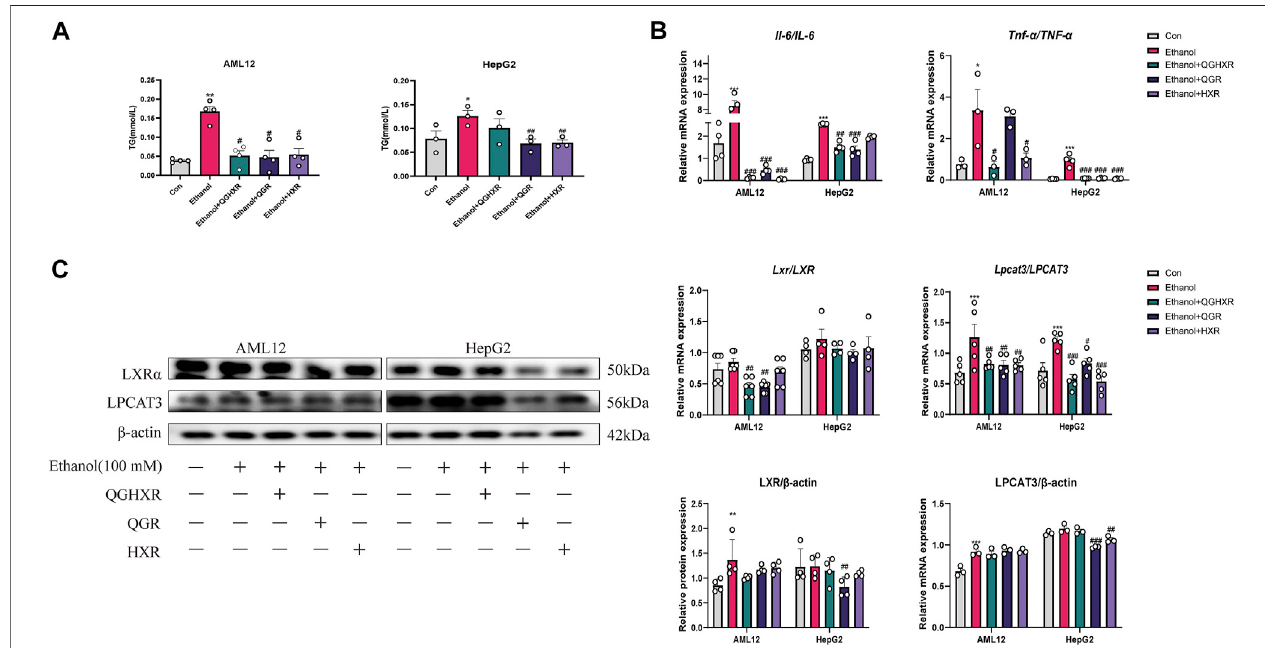
FIGURE 3 | Protective effect of QGHXR against alcohol-induced liver injury in AML12 and HepG2 cell involved modulation of LXR α and LPCAT3. (A) Level of TG (mmol/L) in AML12 and HepG2 cell. (B) mRNA expression of Il-6 and Tnf- α in AML12 cell and HepG2 cell. (C) mRNA and protein expression of LXR and LPCAT3 in AML12 and HepG2 cell. Con: normal control group, ethanol: ethanol group (100 mM), ethanol+ QGHXR: Qinggan Huoxue Recipegroup induced byethanol; ethanol + QGR: Qinggan Recipe group induced by ethanol; ethanol + HXR: Huoxue Recipe group induced by ethanol. Quanti fi cation of mRNA and protein level expression wasnormalizedto β -actinlevels.Datawerepresentedasmeans±SEM.Comparedwiththenormalcontrolgroup,* p < 0.05,** p < 0.01,*** p < 0.001;Comparedwiththe ethanol group, # p < 0.05, ## p < 0.01, ### p < 0.001.